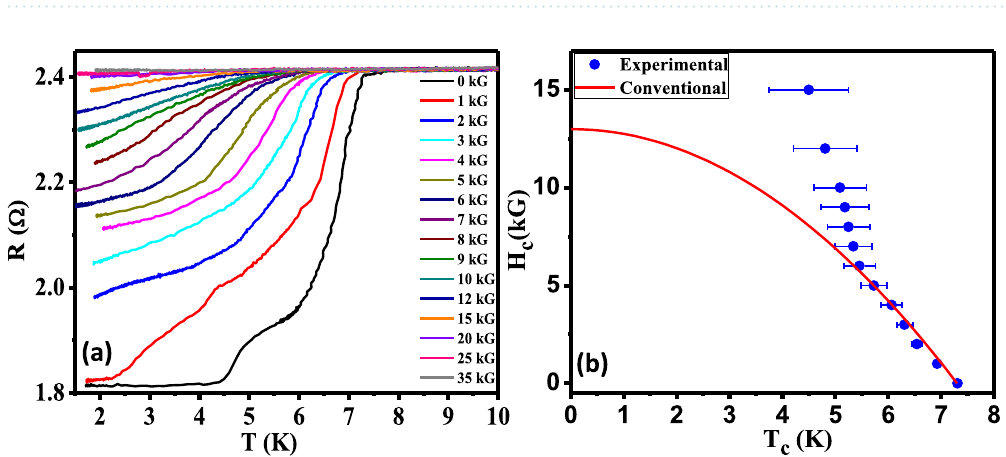
Figure 6. ( a ) Magnetic field dependence of the R-T curves. ( b ) H-T phase diagram. The red line shows the empirical plot for a conventional superconductor. The blue dots are the data points extracted from the curves in ( a